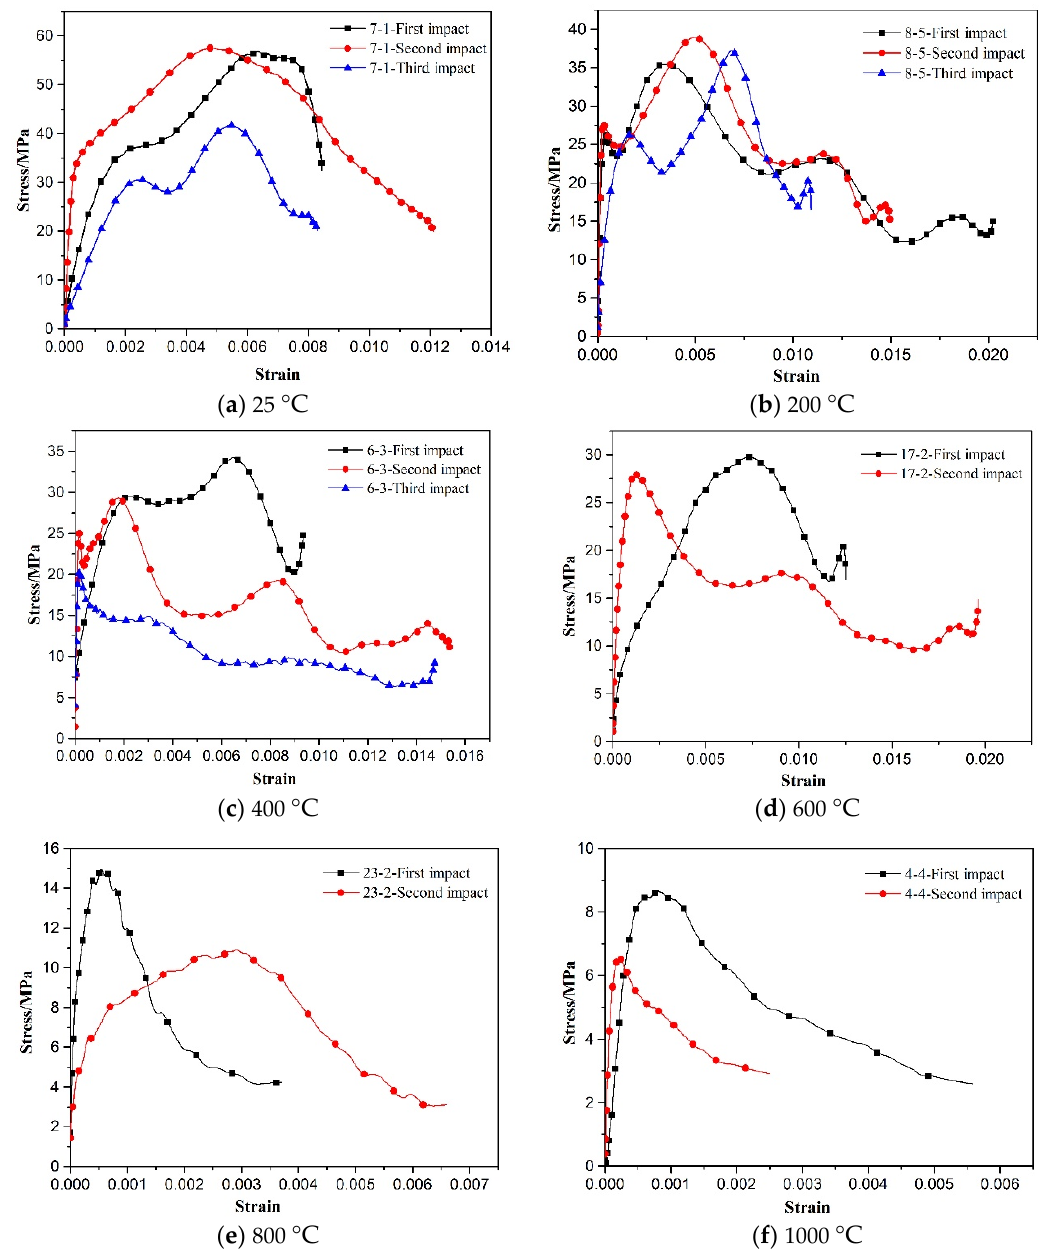
Figure 11. Cyclic impact stress ‒ strain curves of sandstone after different temperatures.